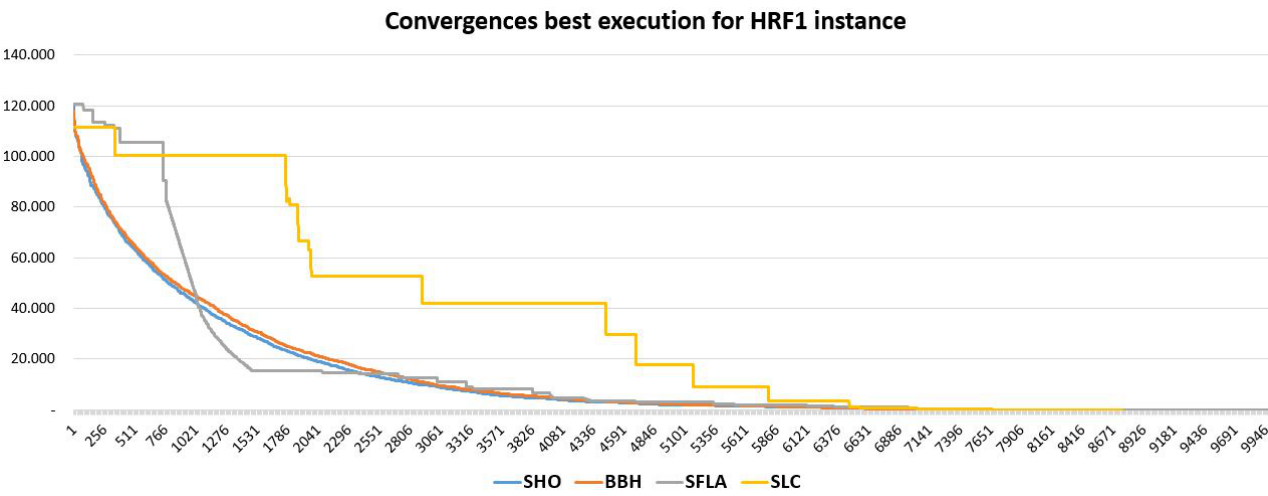
Figure 7. Convergences best execution of HRF1